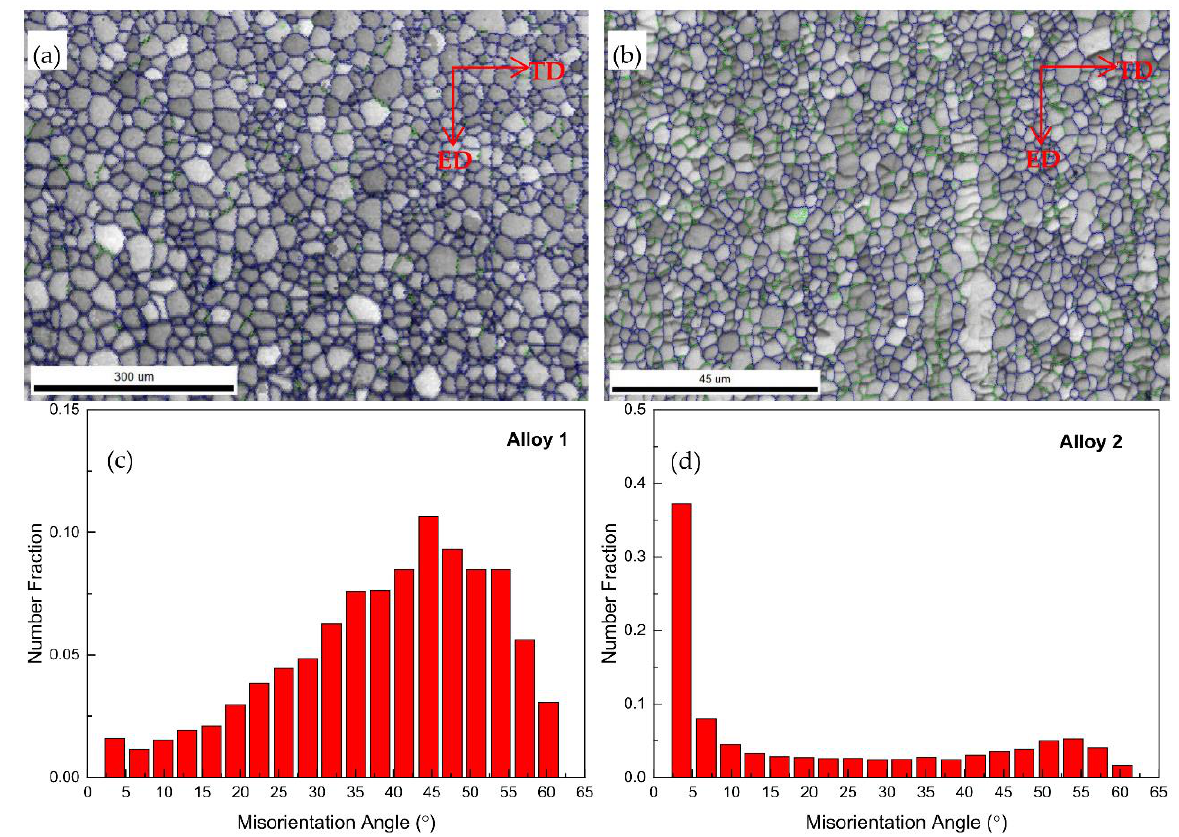
Figure 2. Grain boundary misorientation of alloy 1 ( a , c ) and alloy 2 ( b , d ) after hot extrusion: ( a , b ) GBM maps; ( c , d ) misorientation angle distribution. Table 3. Comparison of statistical grain boundary misorientation for two categories of extruded Al-5Mg alloys.